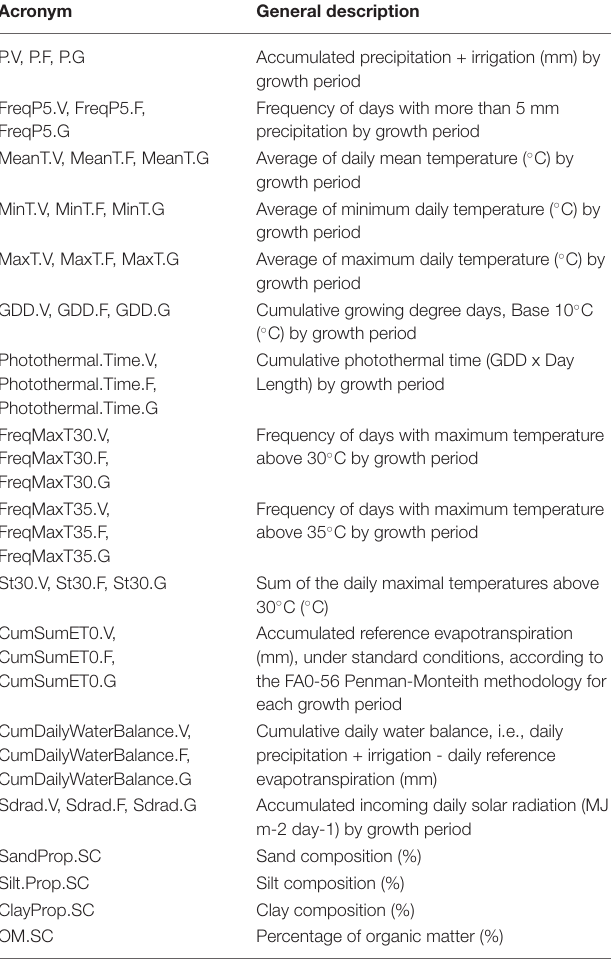
TABLE 1 | Environmental predictor variables used in the prediction